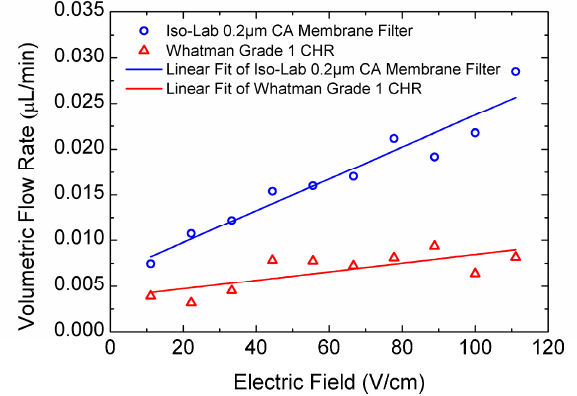
Figure 6. Volumetric flow rates of the pumps made with Whatman paper and CA membrane filter with different electrical field magnitudes, measured inside their microfluidic channels.